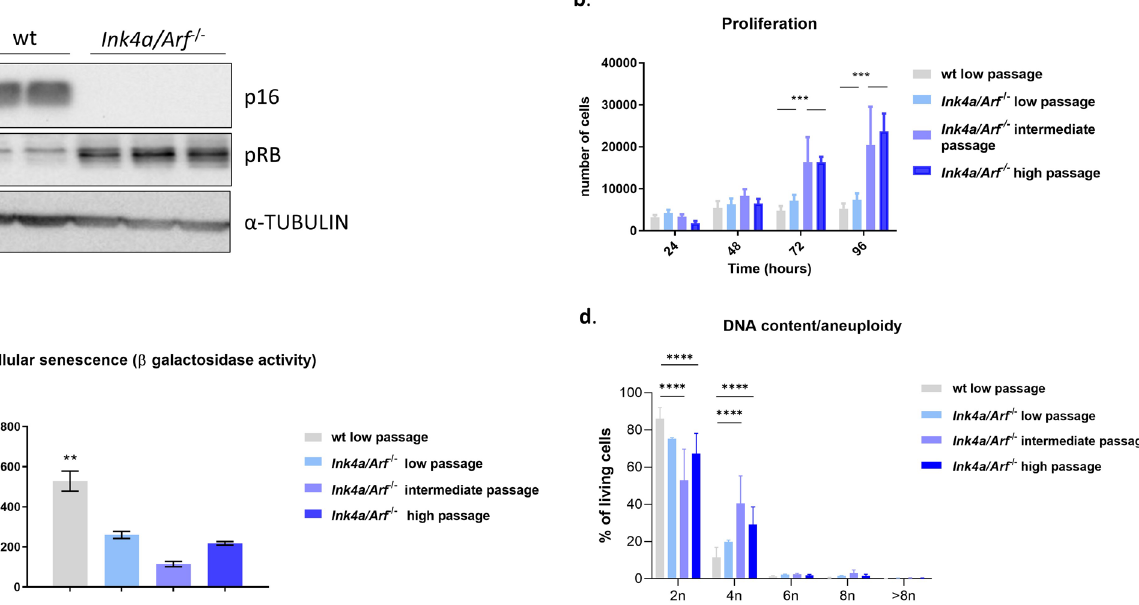
Figure 1. Characterization of Ink4a/Arf − / − compared to wild-type (wt) tenocytes (n = 3 different